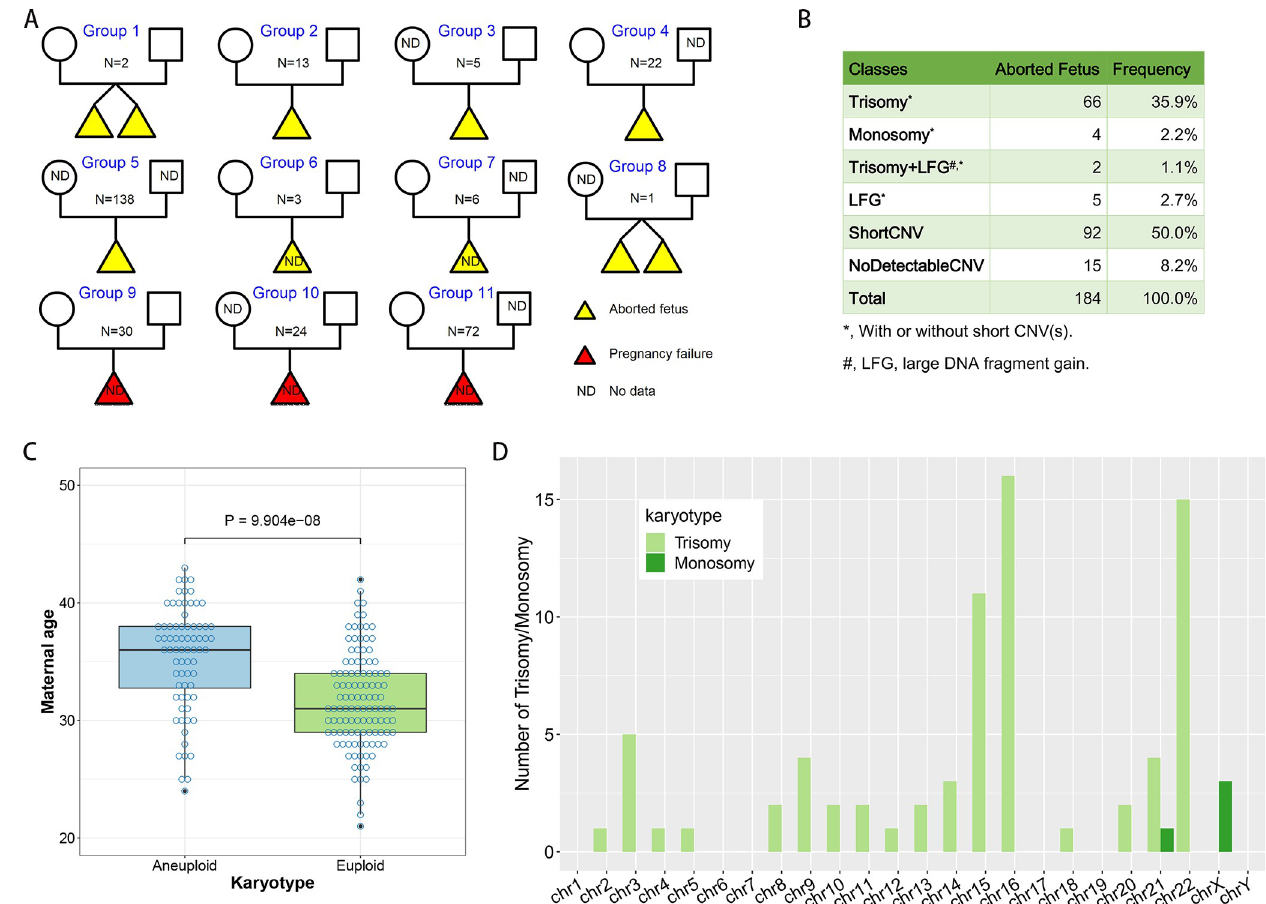
Fig 1. Sample collection and analysis of aneuploidy fetus. (A) Family information of the chromosomal microarray data. (B) Statistics of detected chromatin gains or losses in ART-aborted fetal samples. (C) Aneuploidy of fetus increased with maternal age. (D) The frequencies of chromosome trisomy or monosomy for each